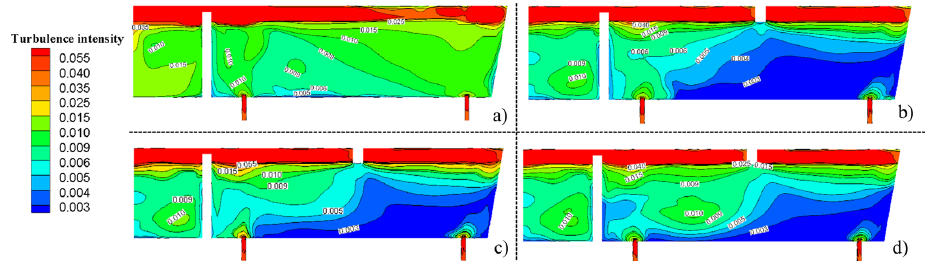
Figure 11. Turbulence intensities of a vertical section in the tundish heated by plasma under different heating powers. ( a ) Without plasma heating, ( b ) 300 kW, ( c ) 500 kW and ( d ) 1000 kW.